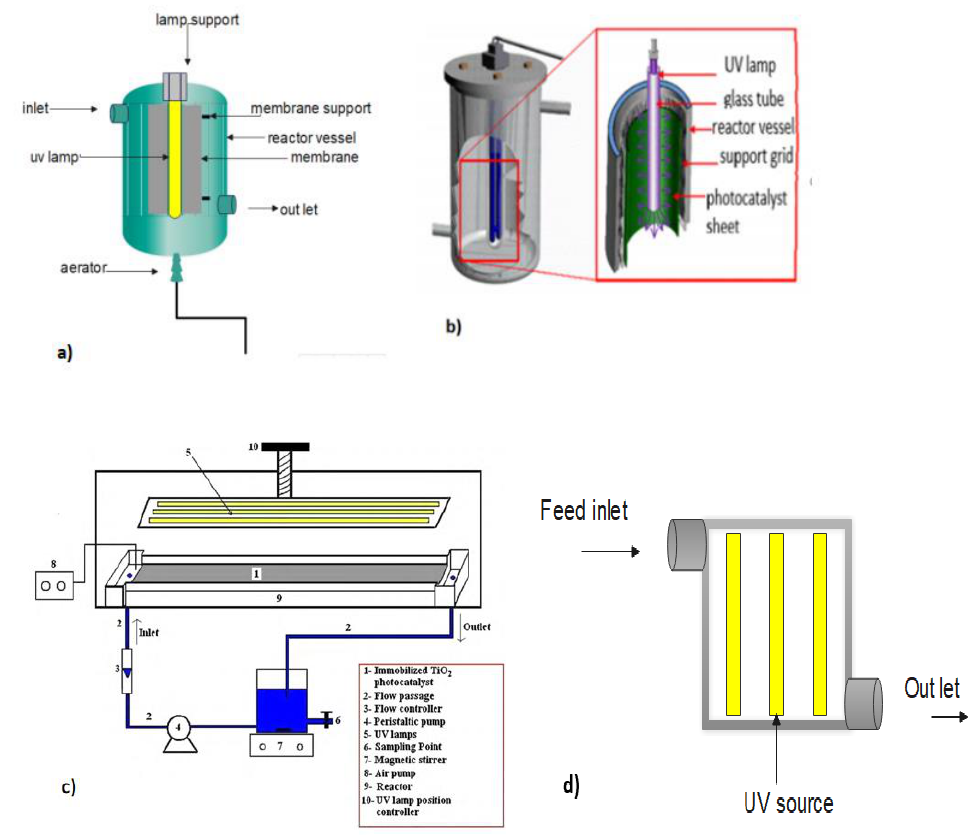
Figure 10. Illustration of different PMR geometries: ( a ) annular tubular reactor; ( b ) batch annular reactor, reproduced with permission from [180], Copyright 2019 Springer; ( c ) continuous flat rectangular reactor, reproduced with permission from [181], Copyright 2010 Elsevier; and ( d ) vertical flat plate reactor (this figure is an adaptation of figure contained in [182]).